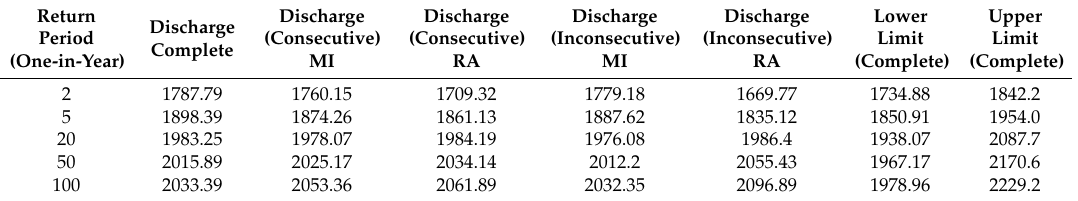
Table 11. Taoussa flood quantile estimates (m 3 /s) and uncertainty boundaries for complete historical data and consecutively and inconsecutively gapped data filled using the MI and RA approaches.